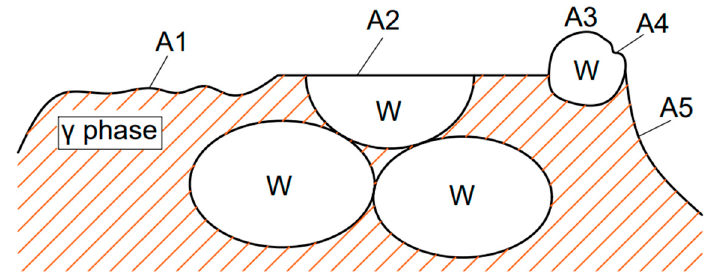
Figure 8. Fracture modes of tungsten alloys [19].